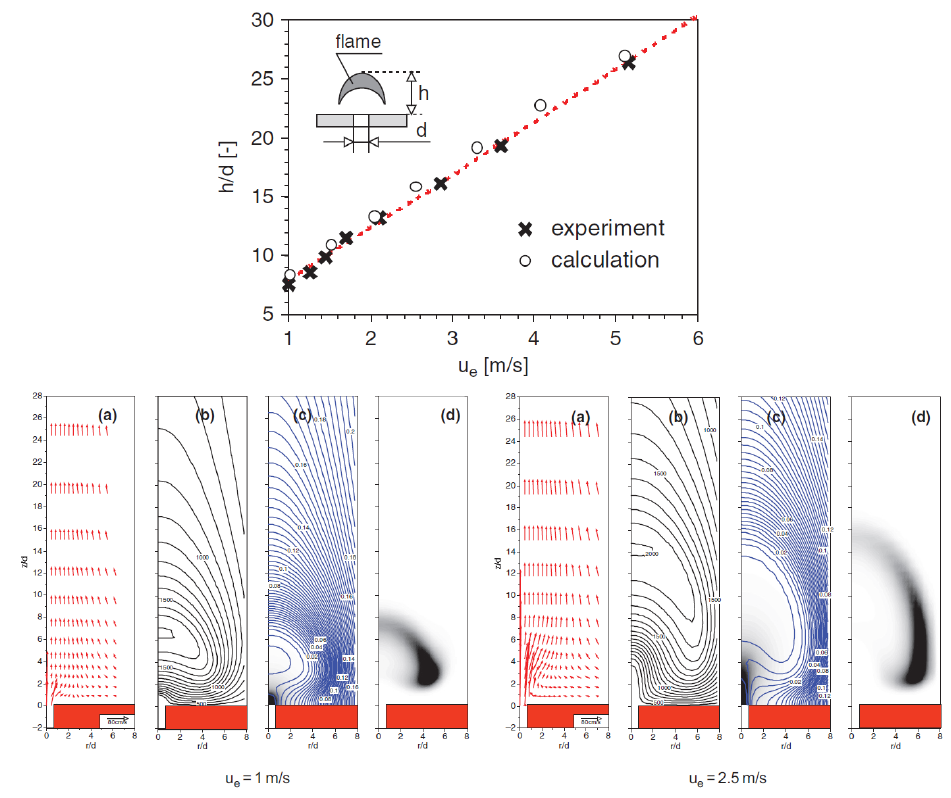
Figure 1. Comparison between experimental and numerical simulations of a micro diffusion flame using methane and air by Nakamura et al. [10]. Top : Simulation results against experimental data of the flame height as a function of the methane inlet velocity, u e ; Bottom : 2D profiles of the simulation results for u e = 1 and 2 m/s: ( a ) flow vectors, ( b ) temperature contours, ( c ) methane and oxygen concentrations ratio, and ( d ) reaction